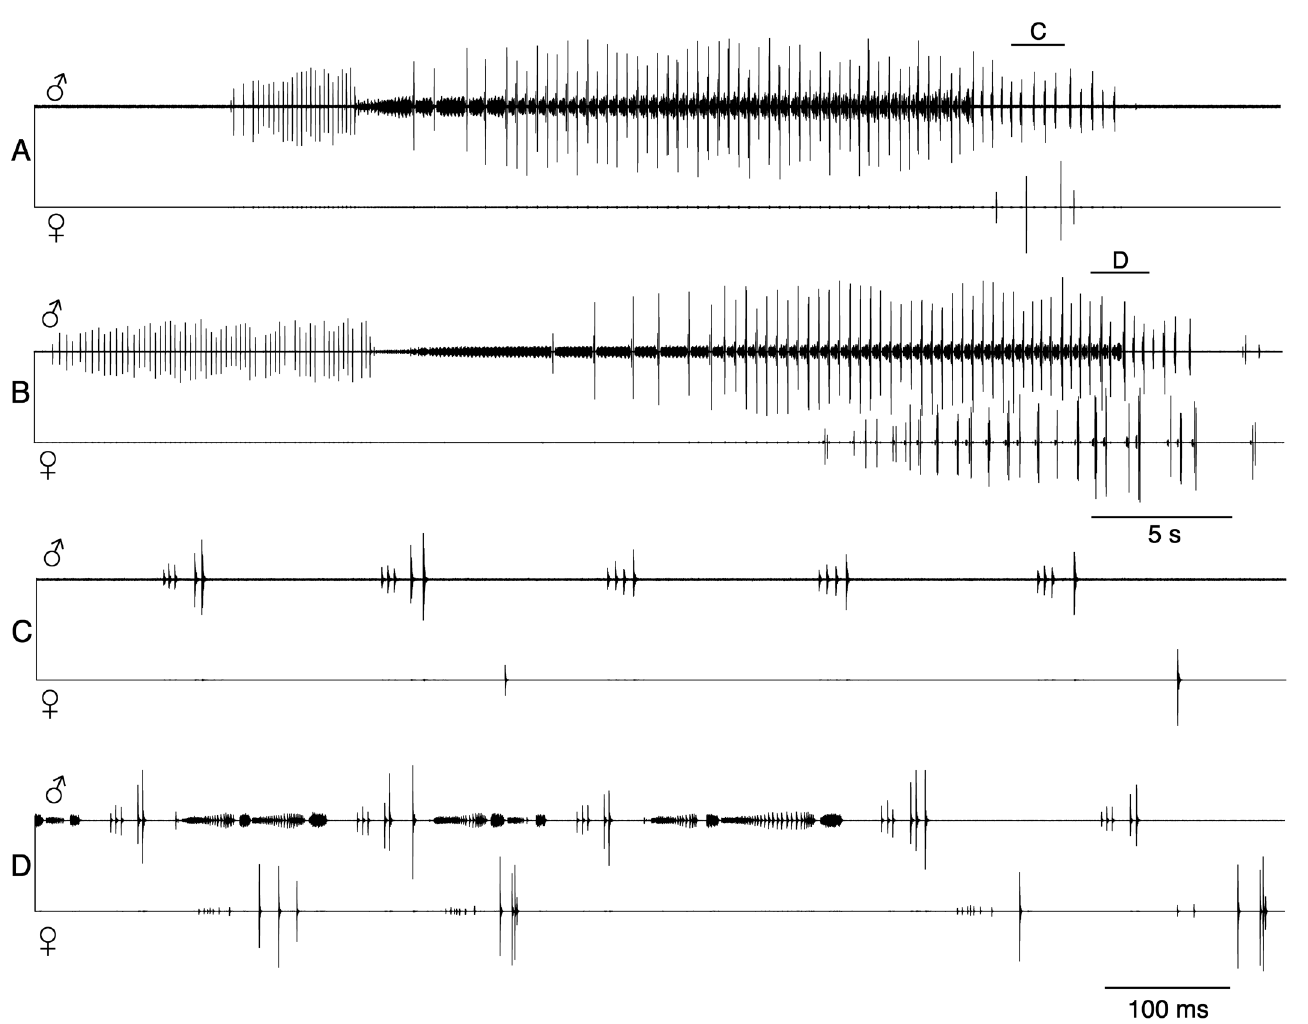
Figure 12. Oscillograms of male calling song and female response of E diuturna sp. n., recorded simultaneously. A, B. Overviews with indication of the origin of the details ( C–D